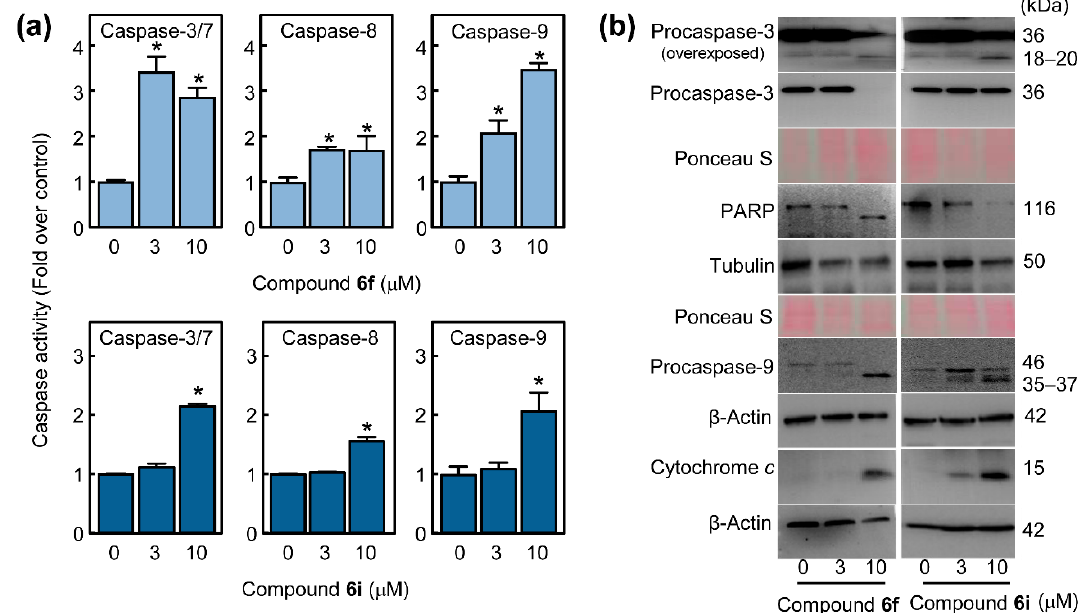
Figure 4. Processing of caspases and PARP (poly(ADP-ribose)polymerase) and mitochondrial cytochrome c release in the apoptosis induced by hybrid compounds on leukemia cells. ( a ) Caspase activation induced by guanidines. U-937 cells were treated with the indicated concentrations of compounds and cell lysates were assayed for caspase-3/7, -8, and -9 activities. Results are expressed as n–fold increases in caspase activity compared with the control. Values represent the means ± SE of three independent experiments each performed in triplicate. * indicates p < 0.05 for comparison with untreated control. ( b ) U-937 cells were incubated with the indicated concentrations of guanidines for 24 h and the cleavage of caspases and PARP and cytochrome c release were analyzed by immunoblotting. β -Actin and tubulin were used as loading controls. Equal loading was also controlled by staining the membranes with Ponceau S before antibody detection.